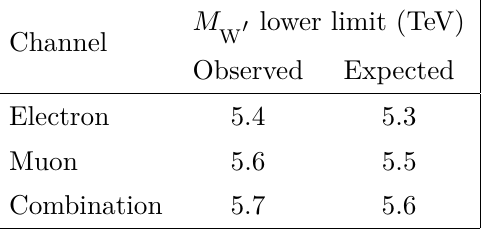
Table 2 . Observed and expected lower limits at 95% CL on the SSM W 0 boson mass for the electron and muon channels and for the combination of the